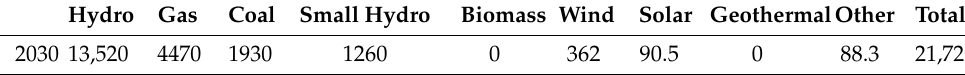
Table 7. Reference power capacity mix [MW], [42].